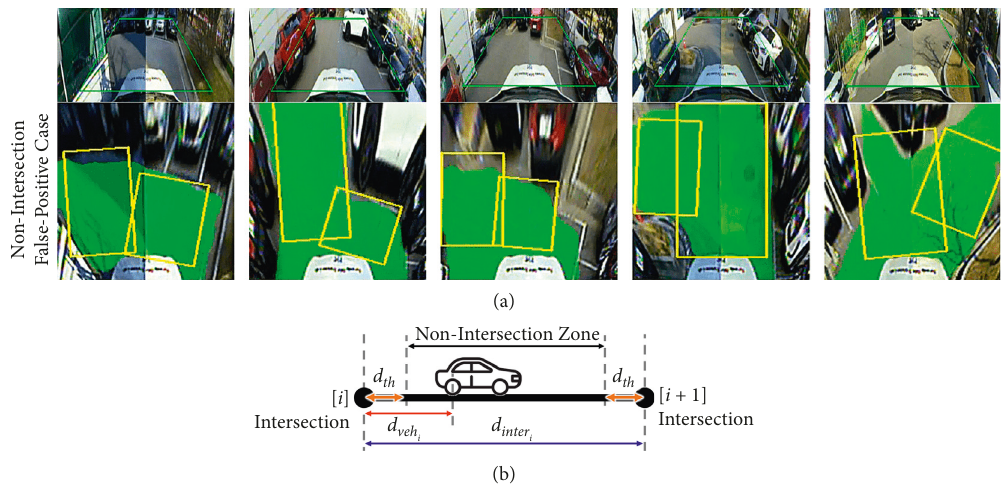
Figure 7: (a) Two or more road boxes are detected in a nonintersection road: false-positive case. (b) Intersection decision using a distance between intersections and the driving distance additionally.